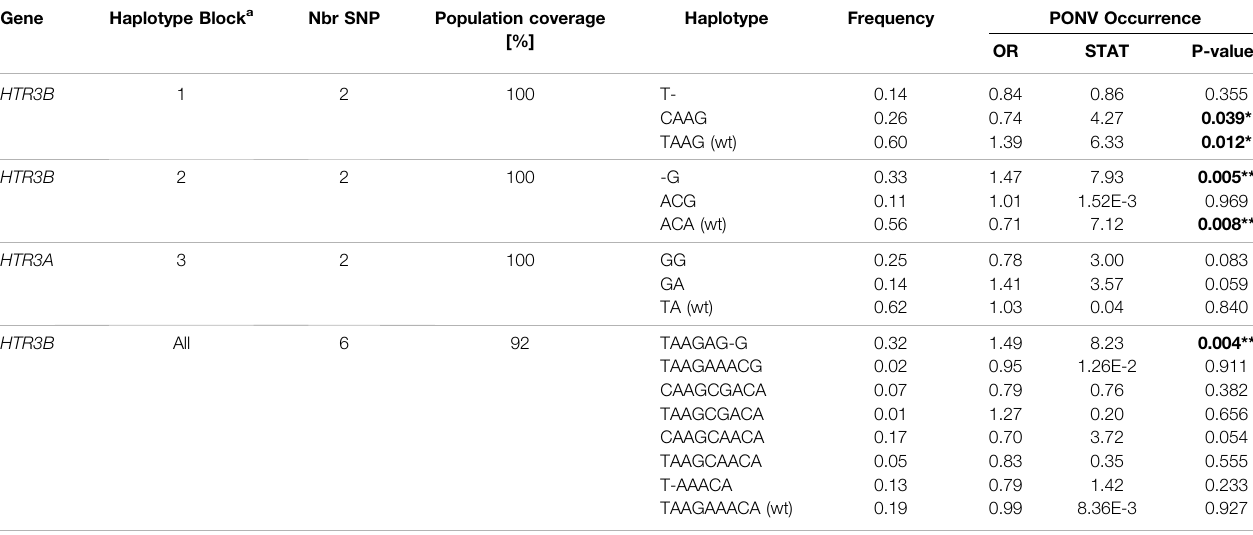
TABLE 5 | Correlations between serotonin receptor haplotypes and PONV occurrence. Gene Haplotype Block a Nbr SNP